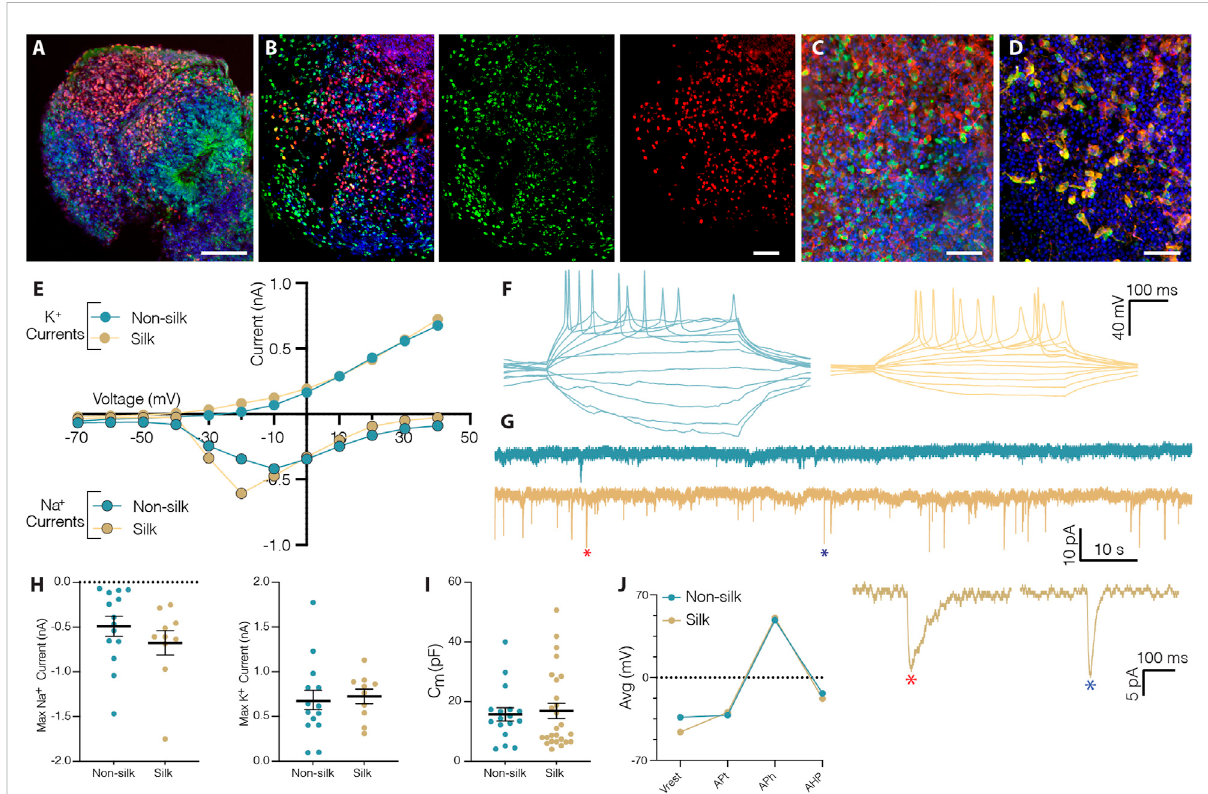
FIGURE 3 Silk scaffolding sustains functionally mature neurons generation. (A) Immunohistochemistry of FOXG1/CTIP2 showing cortical plate layer formation insilk brain organoidat day 60. Scale bar 100 µm. (B) Cryosectionof silk brain organoidat day120 showing SATB2/CTIP2 double staining. Scale bar50 µm. (C,D) Immunohistochemistry of (C) VGLUT1/MAP2, (D) GABA/MAP2 showing distinct neuronal identitieswithin silkbrain organoids at day 120. Scale bars 50 µm. (E) Inward Na + and outward K + currents plotted as a function of stepwise voltage induction of cells in non-silk (n=14) andsilk(n= 10)organoidsat3months. (F) Representativetraceofevoked actionpotentials underrheobase currentinjectionsteps ofcellsin non-silkandsilkorganoidsafter3monthsinculture. (G) Sampletracesofspontaneousactivityrecordedinvoltageclamp,includingmagni fi cationof selected postsynaptic events. (H) Quanti fi cation of maximum inward sodium current and maximum outward potassium current in silk (n = 14) and non-silk (n = 10) organoids after 3 months inculture. (I) Quanti fi cation of membranecapacitance insilk (n = 26)and non-silk (n = 17) organoids after 3 months in culture (J) Average value of action potential (AP) properties, resting membrane potential (V rest ), AP threshold (AP t ), AP amplitude (AP h